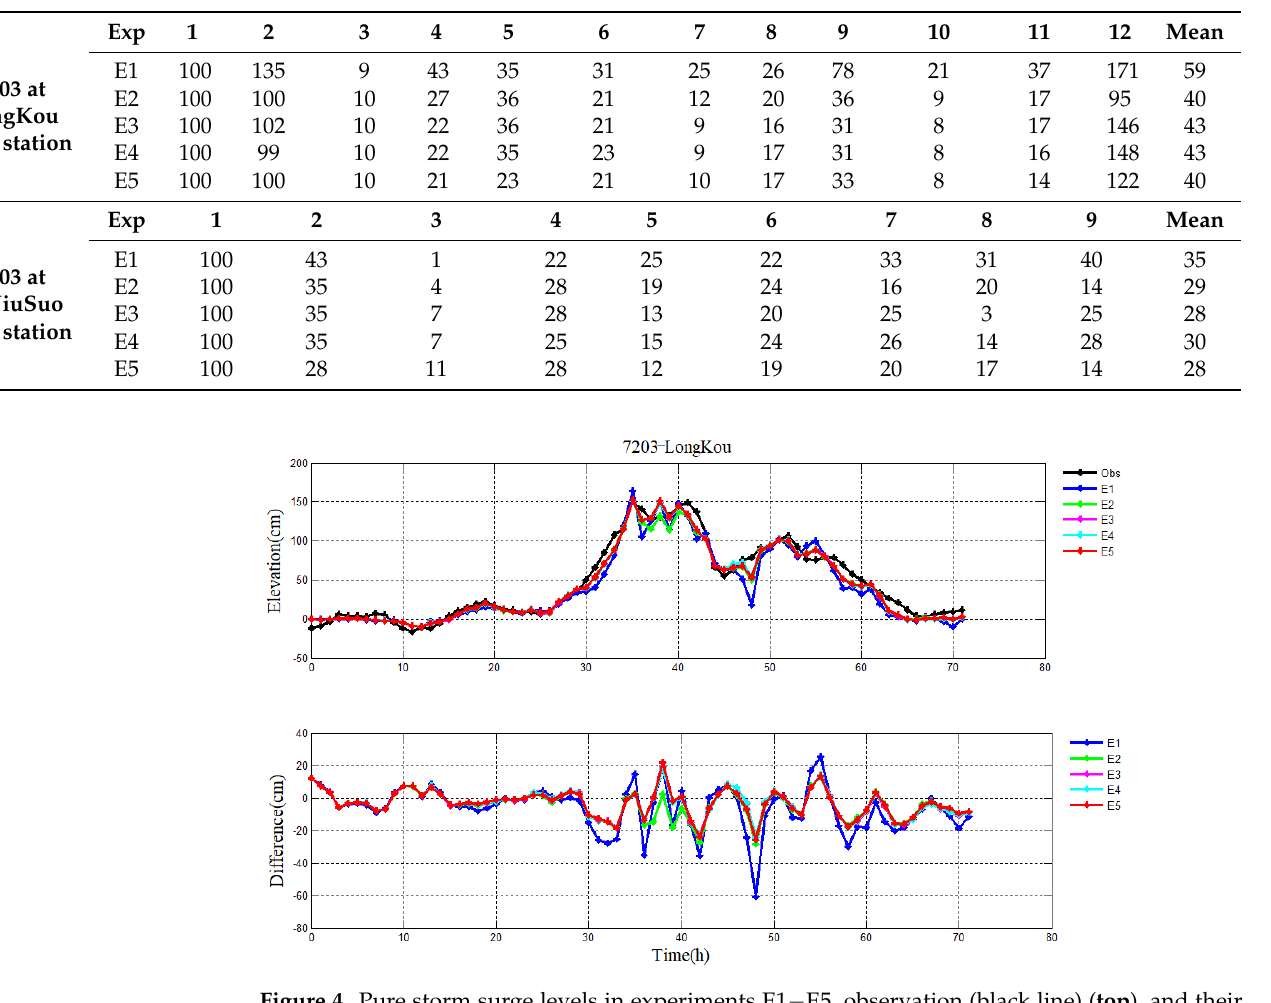
Figure 4. Pure storm surge levels in experiments E1 − E5, observation (black line) ( top ), and their differences ( bottom ) during Typhoon 7203 at LongKou station.